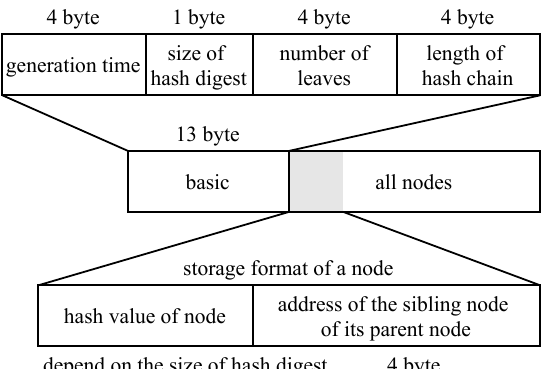
Figure 6. Binary format of the Merkle tree.